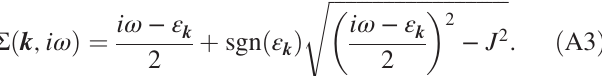
FIG. 8. Diagrams for the computation of σ model of Eq.